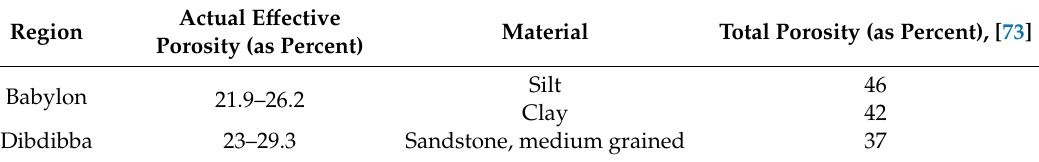
Table 1. Actual e ff ective porosity in the study area (obtained from the Iraqi Ministry of Water Resources and Al-Qadisiyah University, Iraq) compared with the total porosity stated in the